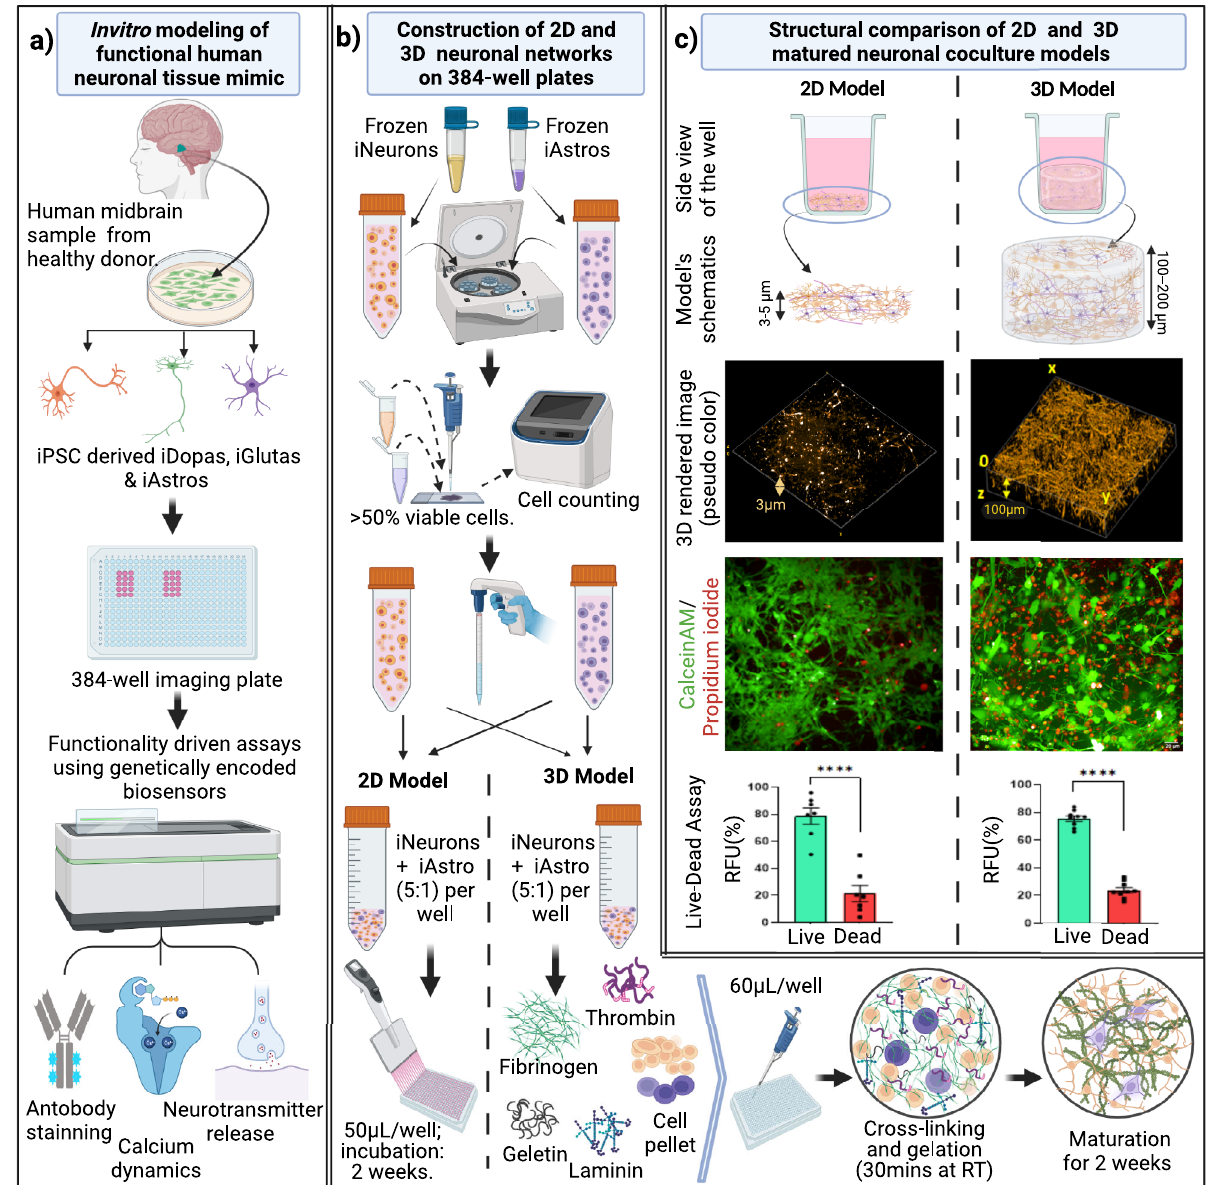
Fig. 1 Schematic for the biofabrication of functional 3D gel-based neural co-culture cellular models for high content screening in a multi-well plate platform. a The neural coculture models were developed using iPSC derived post-mitotic midbrain dopaminergic or glutamatergic neurons with iPSC-derived astrocytes from healthy human donor in 384 well fl at bottom imaging plates. We designed three functionality driven assays with spatiotemporal resolution using genetically encoded biosensors: (i) Measurement of single cellular level ‘ in-network ’ calcium dynamics over time with CAG-GCaMP6f sensor. (ii) Assessment of released dopamine neurotransmitter at the synaptic cleft with hSyn-dLight1.2 sensor. (iii) Detection of glutamate neurotransmitter within network with hSyn-GluSnFr sensor. b Flow chart for the assembly 2D and 3D gel-based neural models. Frozen human iPSC derived neurons and astrocytes were thawed, counted, and mixed at the desired ratios. For 2D co-cultures, plates were coated with PLO-laminin and 50 µ l of the cell suspension in media was pipetted into the wells. For 3D gel-based co-cultures, 60 µ l of cell suspension in a mixture of fi brinogen (2.5mg/ml), gelatin (60 mg/ml), laminin (1mg/ml) and thrombin (1:1000U) in media were quickly pipetted in the wells before gelation. c After gelation and maturation, the 3D fi brin gel structure was 100 – 200 µ m thick compared to 3 – 5 µ m thin 2D co-cultures. After 14days, a z-stack of confocal bright fi eld images (pseudo-orange color) from 3D system indicates horizontal as well as vertical progression of neurites through the gel matrix, whereas the images from 2D system (pseudo-orange color) does not show any downward spreading of neurites. The calceinAM/propidium iodide live-dead imaging assay con fi rmedthepresence of that80% of the cells were live cells in both models. Error bar s.e.m., three biological replicates, each n = 3. Scale bar 20 µ m. Schematics made in statistical change in the amplitude (Fig. 4f). Apomorphine did not induce any statistical changes in neither basal peak frequency nor in amplitude but showed a 1.7-fold increase in evoked peak frequency ( p < 0.001) and no signi fi cant changes in peak amplitude in 2D (Fig. 4c).